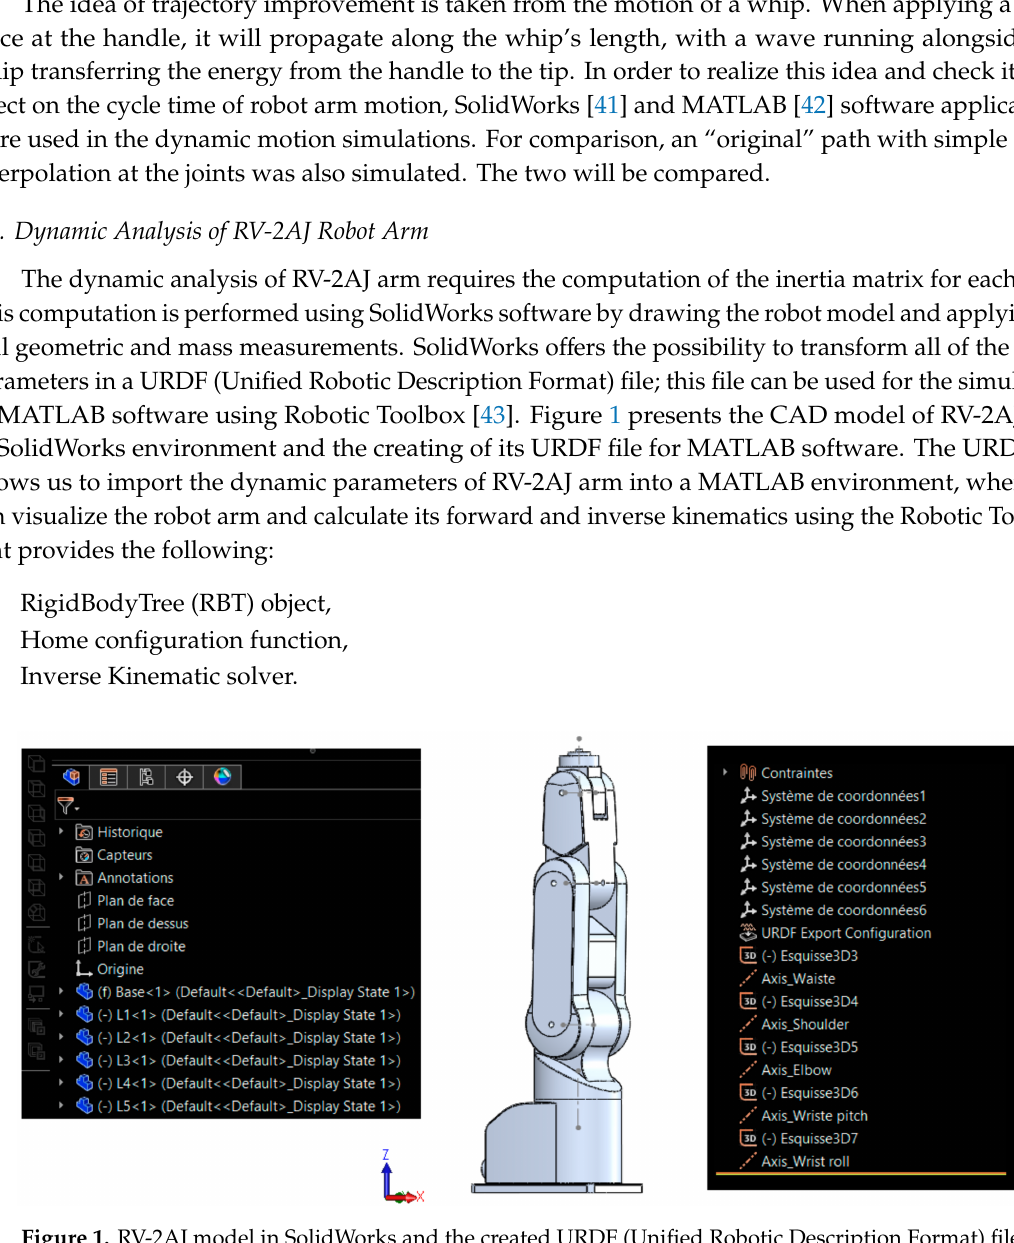
Figure 1. RV-2AJ model in SolidWorks and the created URDF (Unified Robotic Description Format) file for the CAD model of the RV-2AJ